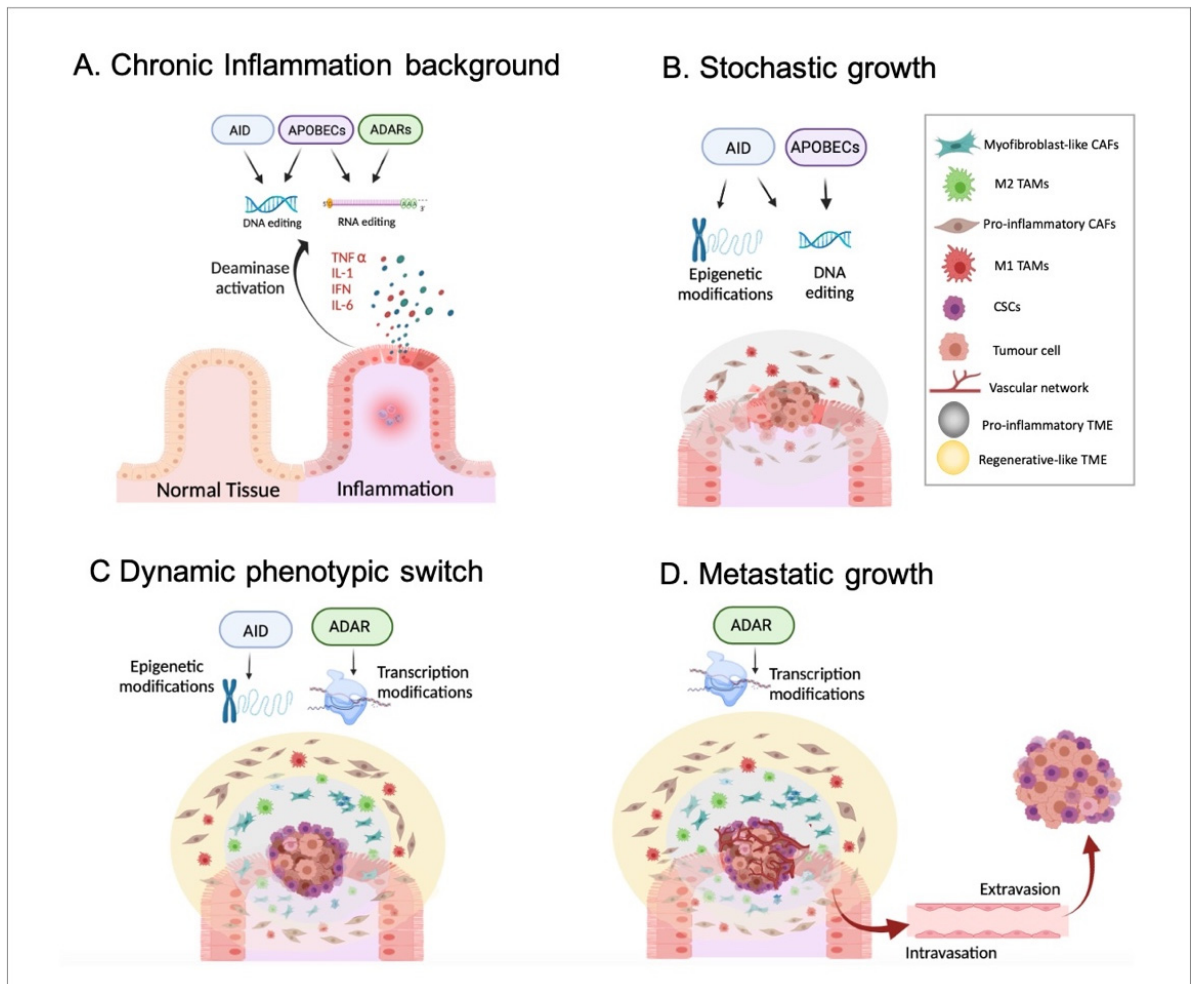
Figure 3. Inflammation, deaminases, and tumour progression. In Panel ( A ), a background of chronic and non-resolved inflammation that may alter the activity of both DNA- and RNA-based deaminases, including AID, APOBECs, and ADARs is presented. In Panel ( B ), the emergence and stochastic growth of the primary tumour in the earliest stages are shown. The collaboration of both epigenetic and genetic alterations driven by DNA-based deaminases in the emergence of malignant cells is highlighted. Moreover, DNA-editing may induce the appearance of genetically distinct cancerous cell subpopulations according to the stochastic model. Additionally, a pro-inflammatory TME with pro-inflammatory CAFs and M1 TAMs is generated and sustained by, at least partially, APOBEC activity. Panel ( C ) identifies the appearance of CSCs on the edges of the tumour mass in an advanced stage. Non-genetic alterations, such as epigenetic modifications and constitutive RNA editing, may allow a phenotypic switch underlined by the acquisition of a CSC-like phenotype by non-stem cancerous cells located mainly in the borders. Furthermore, the appearance of CSCs may induce the generation of an anti-inflammatory/regenerative TME, with myoCAFs and M2 TAMs, just adjacent to CSCs. In such events, ADARs may play a relevant role by promoting an anti-inflammatory response. Panel ( D ) shows the final stages of tumour progression in which CSCs may migrate (through intravasation and extravasation) and generate a metastatic tumour with a hierarchical organization. It seems reasonable to assume that there is an important role played by ADAR RNA editing in the phenotypic switch during the differentiation of CSCs into well-differentiated cancer cell